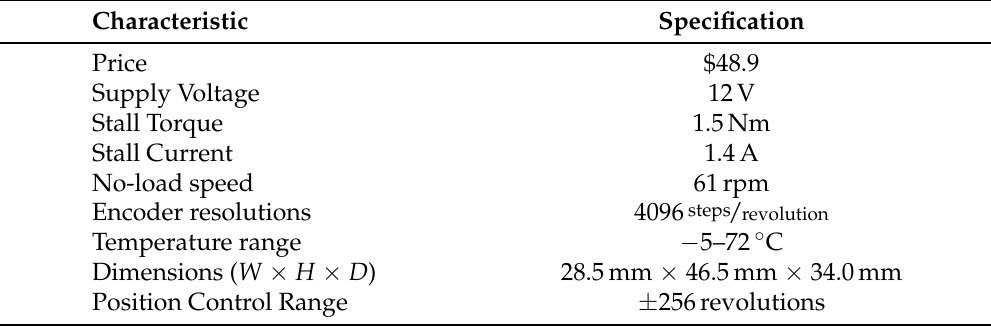
Table 2. Dynamixel XL430-W250-T specification according to the manufacturer. Of importance are especially the encoder resolution and the position control range, as well as a sufficient torque.